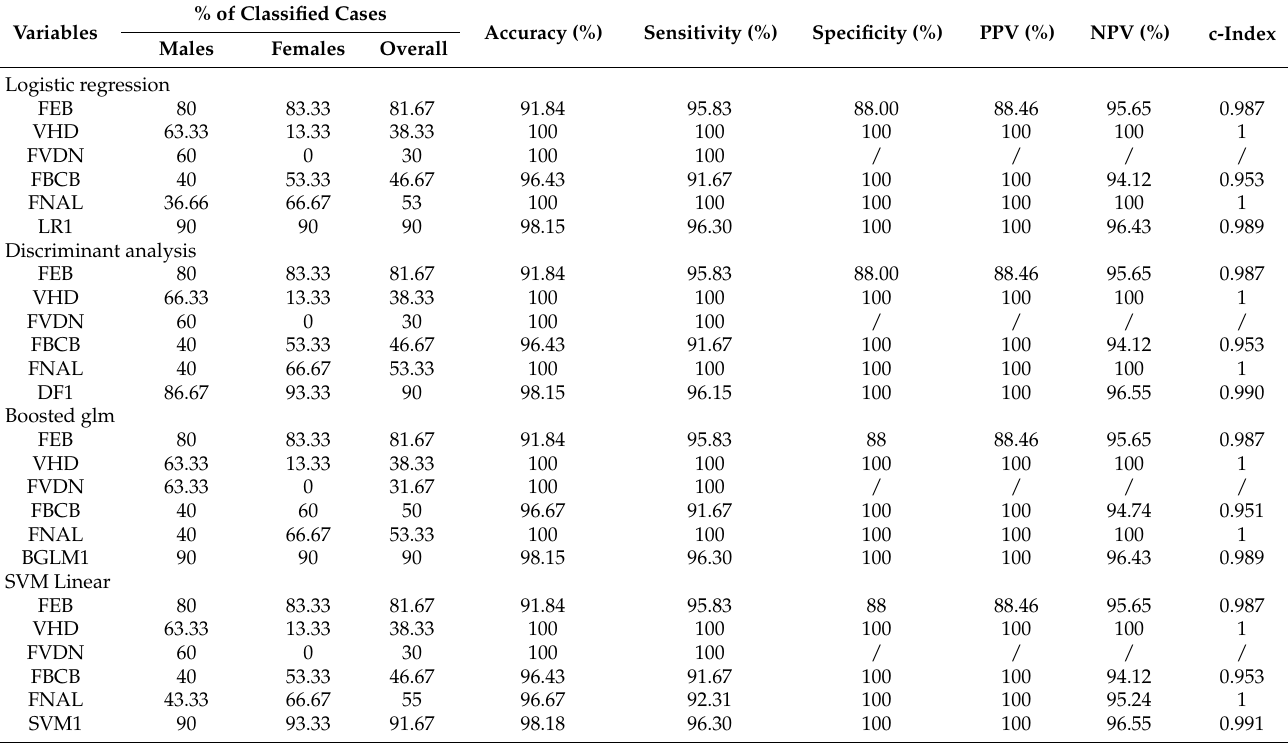
Table 4. Classification results in the testing sample with ABC adjustment ( n =